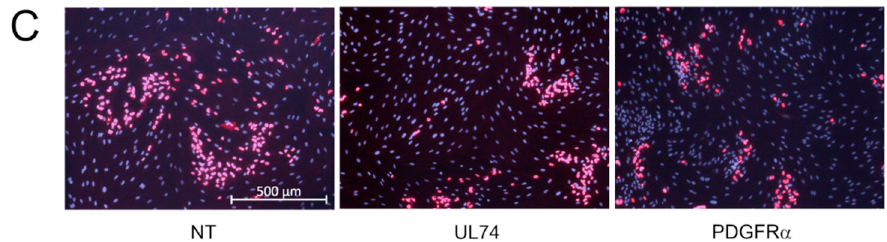
Figure 4. Knockdown of viral glycoprotein O (gO) and its cellular receptor PDGFR α both reduce the growth of cell-associated clinical HCMV isolates. Human fibroblasts infected with recent HCMV isolates were transfected with siRNAs targeting transcripts of the viral gene UL74 (encoding gO) or the cellular gene encoding the receptor PDGFR α . Nontargeting siRNAs (NT) were included as a control. ( A ) Four days after transfection, cultures were lysed and analyzed by immunoblotting for expression of gO or PDGFR α , including detection of actin as a loading control. Chemiluminescence signals were analyzed by densitometry, and UL128/actin ratios were calculated and normalized to the NT controls. ( B , C ) Replicates of the transfected cultures were fixed and immunostained for viral immediate early (IE) antigen as an indicator of viral growth. Both knockdown of gO and knockdown of PDGFR α inhibited viral growth to a degree that corresponded to the expression levels of the proteins after siRNA treatment. Bars indicate mean values of three biological replicates (different isolates). Error bars represent the standard error of the mean (SEM). Asterisks indicate significant differences as compared with NT (**, p < 0.01; *, p <